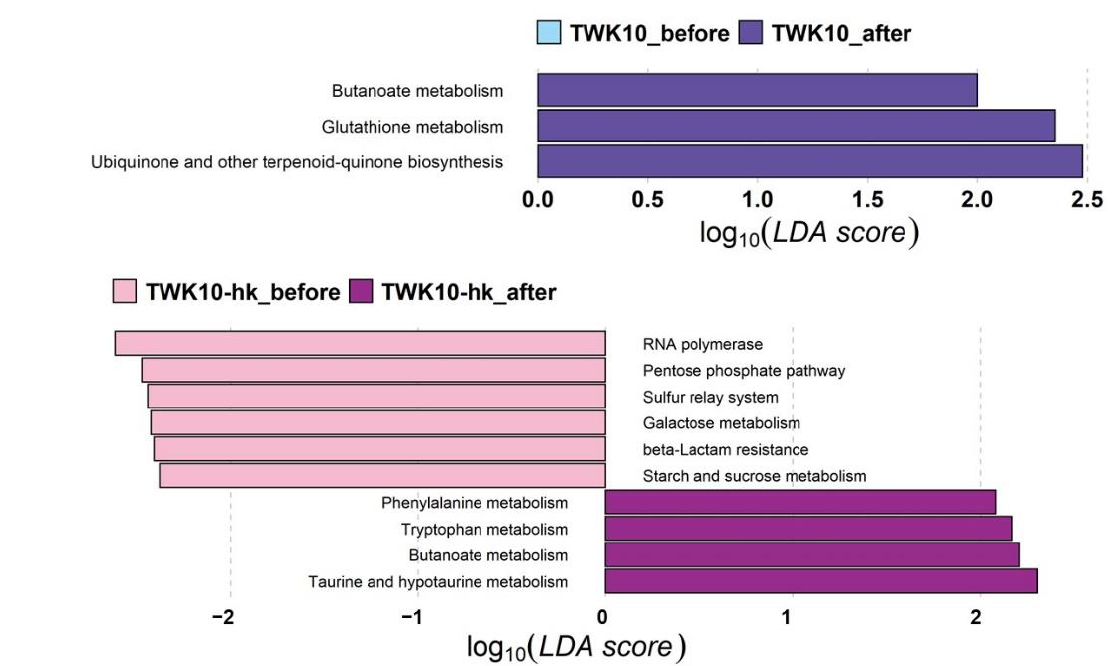
Figure 5. LEfSe analysis of metabolic function profiles using PICRUSt in subjects receiving viable or heat-killed TWK10. Linear discriminant analysis (LDA) effect size (LEfSe) analysis revealed significant differences in functional profiles between before (negative score) and after (positive score) administration in the ( A ) TWK10 and ( B ) TWK10-hk groups. LDA scores (log 10 )>2.0 and P <0.1 are shown.